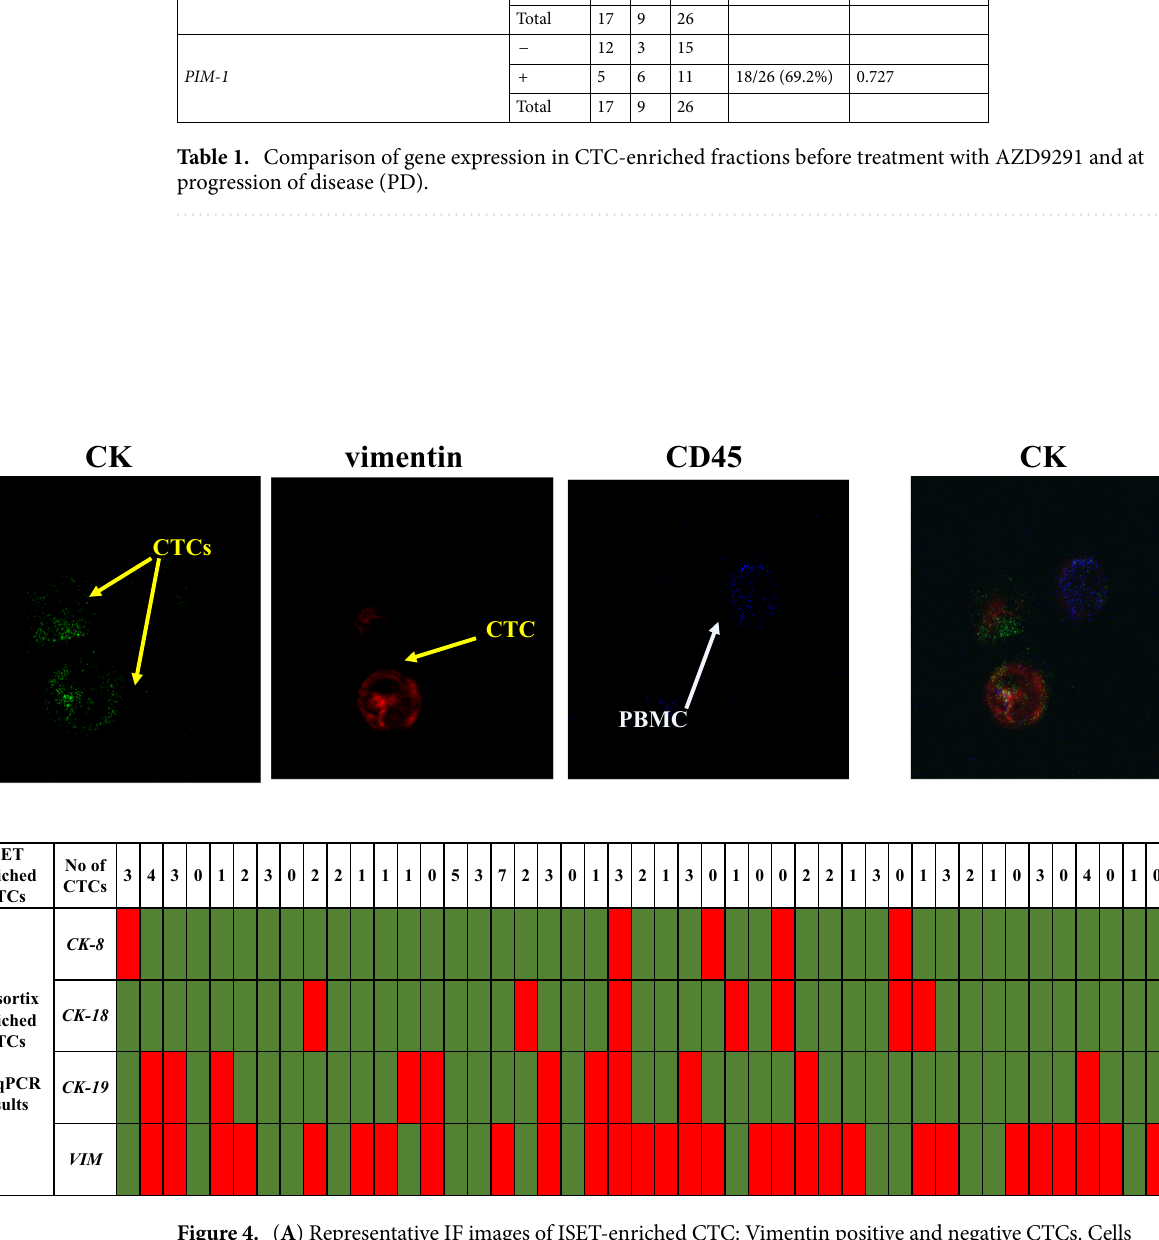
Figure 4. ( A ) Representative IF images of ISET-enriched CTC: Vimentin positive and negative CTCs. Cells were stained with CK (green), Vimentin (red) and CD45 (blue), Dapi (not shown). CTCs phenotypes in NSCLC patients were identified using Confocal laser scanning microscopy (magnification X40), ( B ) Direct comparison of size-based enriched CTC-fractions using molecular analysis at the gene expression level (Parsortix) and IF analysis (ISET), using the same blood draws (n =